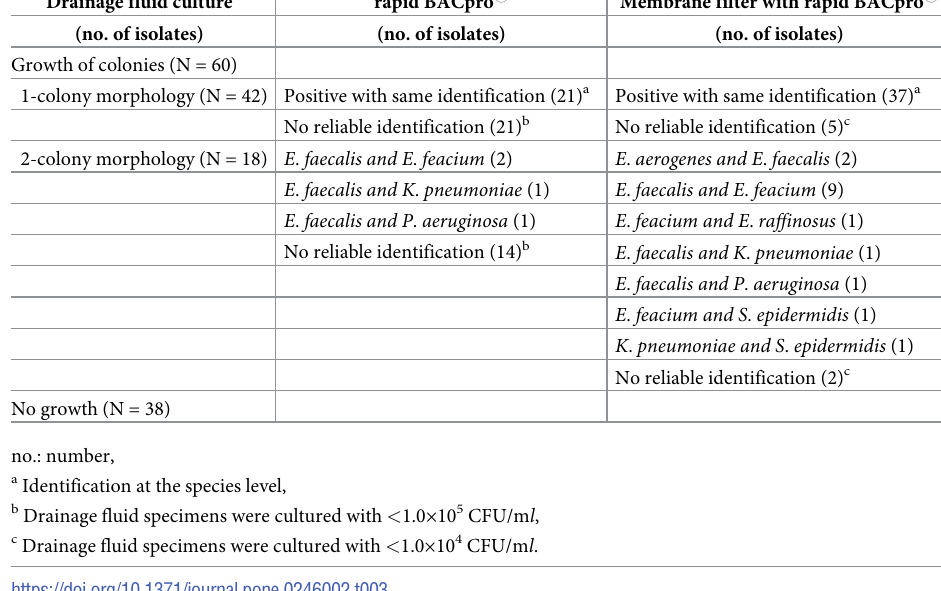
Table 3. Comparison of drainage fluid specimens analyzed by MALDI-TOF MS with two pretreatment methods. Drainage fluid